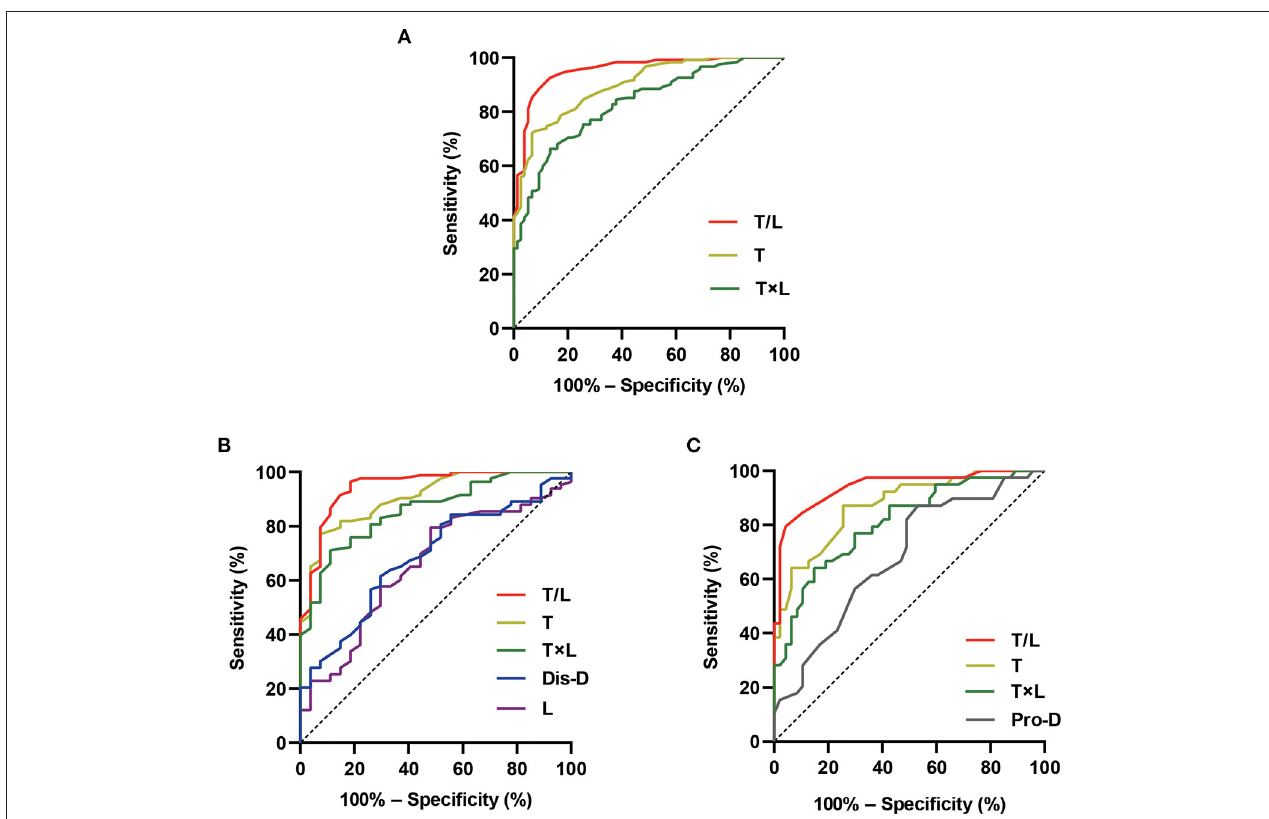
FIGURE 3 | Differential diagnostic performance of the Poincaré plot. The ROC curves show the differential diagnostic performance of the graphic parameters of Poincaré plot in distinguishing VVS from POTS in the total participants (A) , school-aged children (B) , and adolescents (C) in the derivation study. The Y -axis shows the sensitivity to identify VVS; the X -axis shows the false-positive rate [100%–specificity (%)]. The black straight dotted line located in the chart at 45 ◦ to the coordinate axes represents the equivalence between the sensitivity and the false-positive rate (that is, no differential diagnostic value). The areas under the color curves represent the differential diagnostic performance of the graphic parameters of Poincaré plot. The larger the area under the curve, the better the differential diagnostic performance. Dis-D, the distance between the origin and the distal end of the longitudinal axis; L, longitudinal axis; POTS, postural tachycardia syndrome; pro-D, the distance between the origin and the proximal end of the longitudinal axis; ROC, receiver operating characteristic; T, transverse axis; T/L, the ratio of transverse axis value to longitudinal axis value; T × L, the product of transverse axis value and longitudinal axis value; VVS, vasovagal